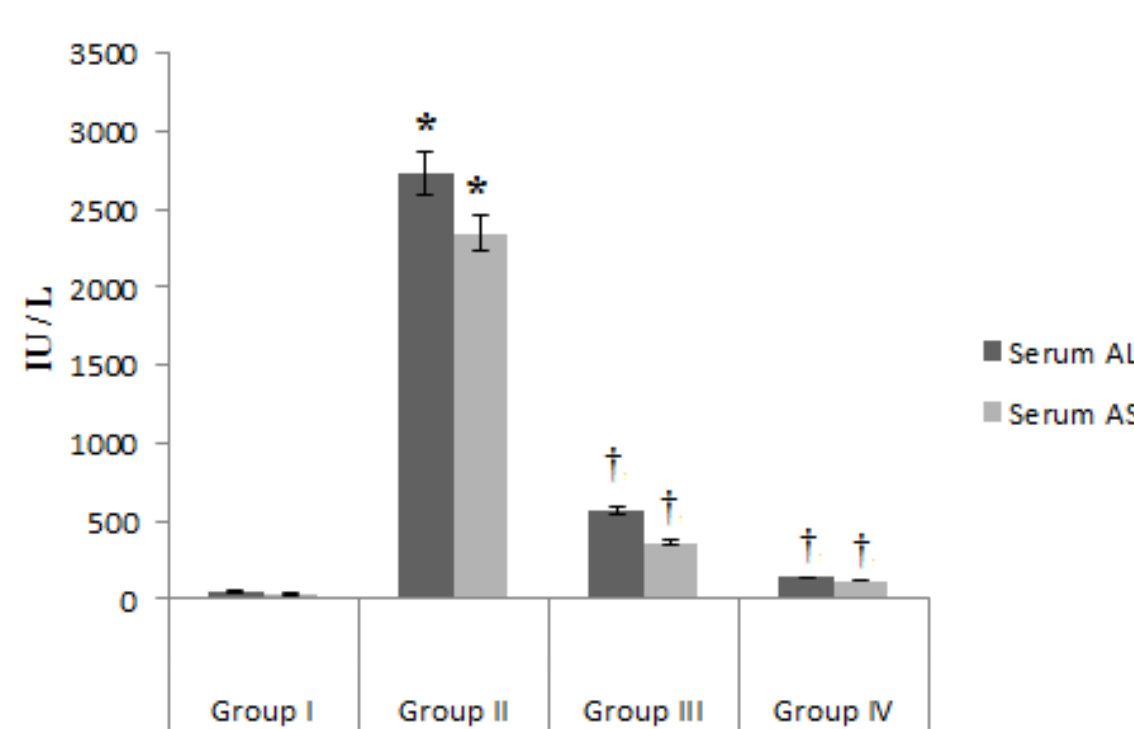
FIGURE 1 - Effects of sitagliptin on APAP-induced alterations on serum ALT (IU/L) and AST (IU/L) levels. Group I: normal control group; group II: APAP-treated group; group III: sitagliptin-treated group (10 mg/kg/day) 5 days before APAP administration; group IV: N -acetylcysteine-treated group (100 mg/kg orally). Data are expressed as mean ± SEM for n = 10. * : P < 0.05 compared to normal control group; †: P < 0.05 compared to APAP control group by one-way ANOVA test followed by post hoc